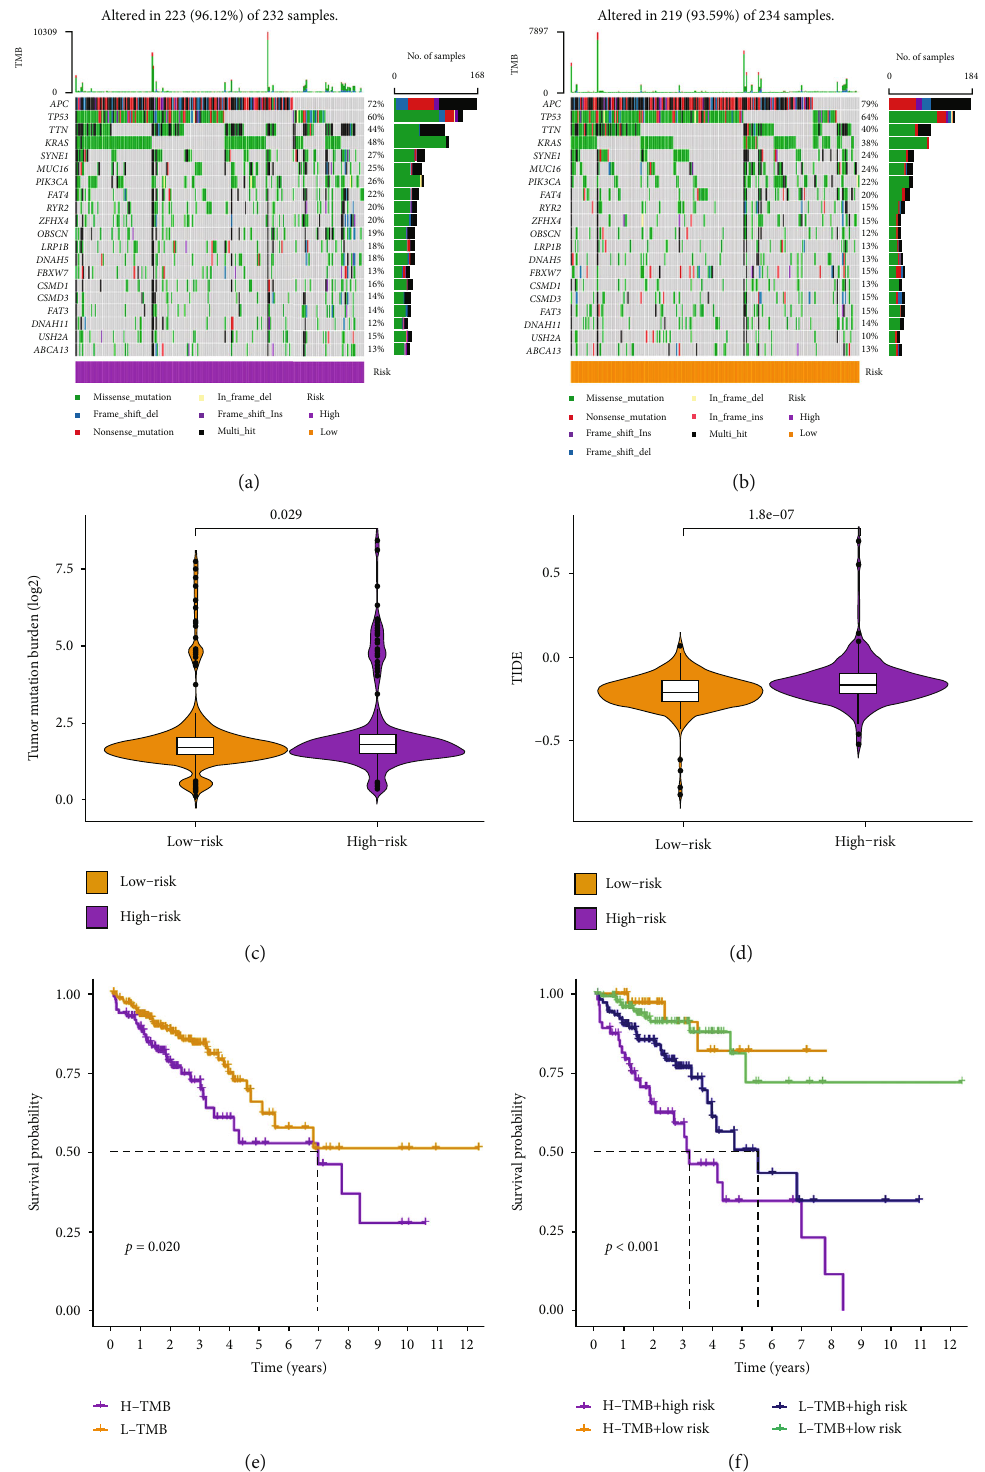
Figure 7: Assessment of immunotherapy response. (a, b) Waterfall plots revealed mutation information for genes with high mutation frequency. (c, d) TMB and TIDE of di ff erent groups. (e) Kaplan-Meier curve analysis di ff erent TMB groups. (f) Kaplan-Meier curve analysis of patient OS according to TMB and di ff erent risk